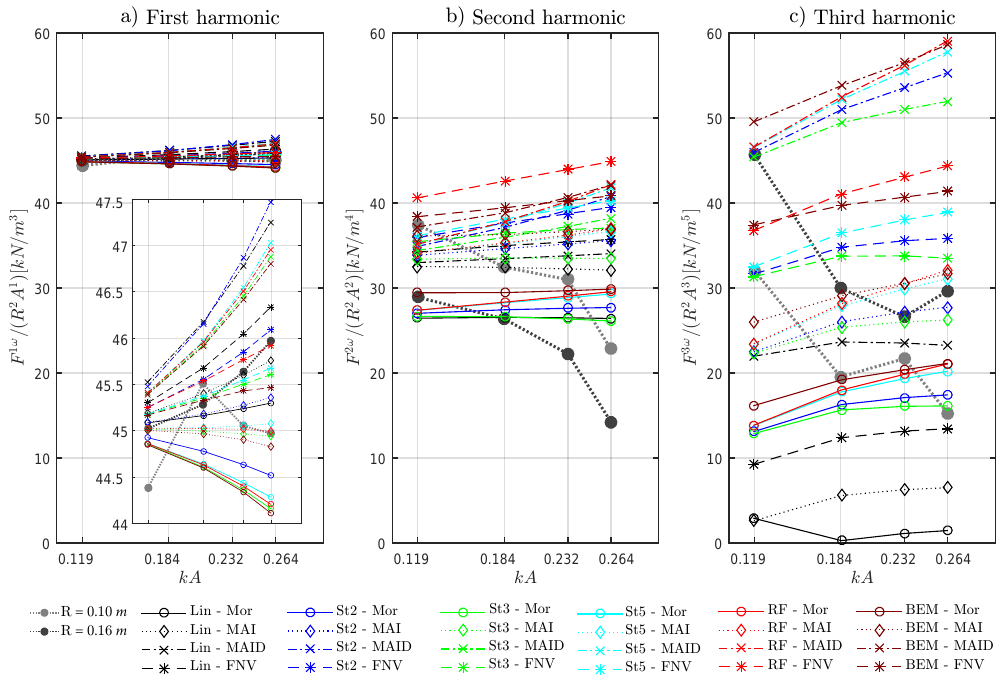
Figure 8. First ( a ), second ( b ) and third ( c ) harmonics of the normalized horizontal force over increasing steepness kA with period T = 2.10 s . Comparison between the experimental results from Stansberg (1997) [21] and numerical loading models. The y-axes are fixed to the same values for easier comparison, therefore a zoom of the first harmonic is provided in panel ( a